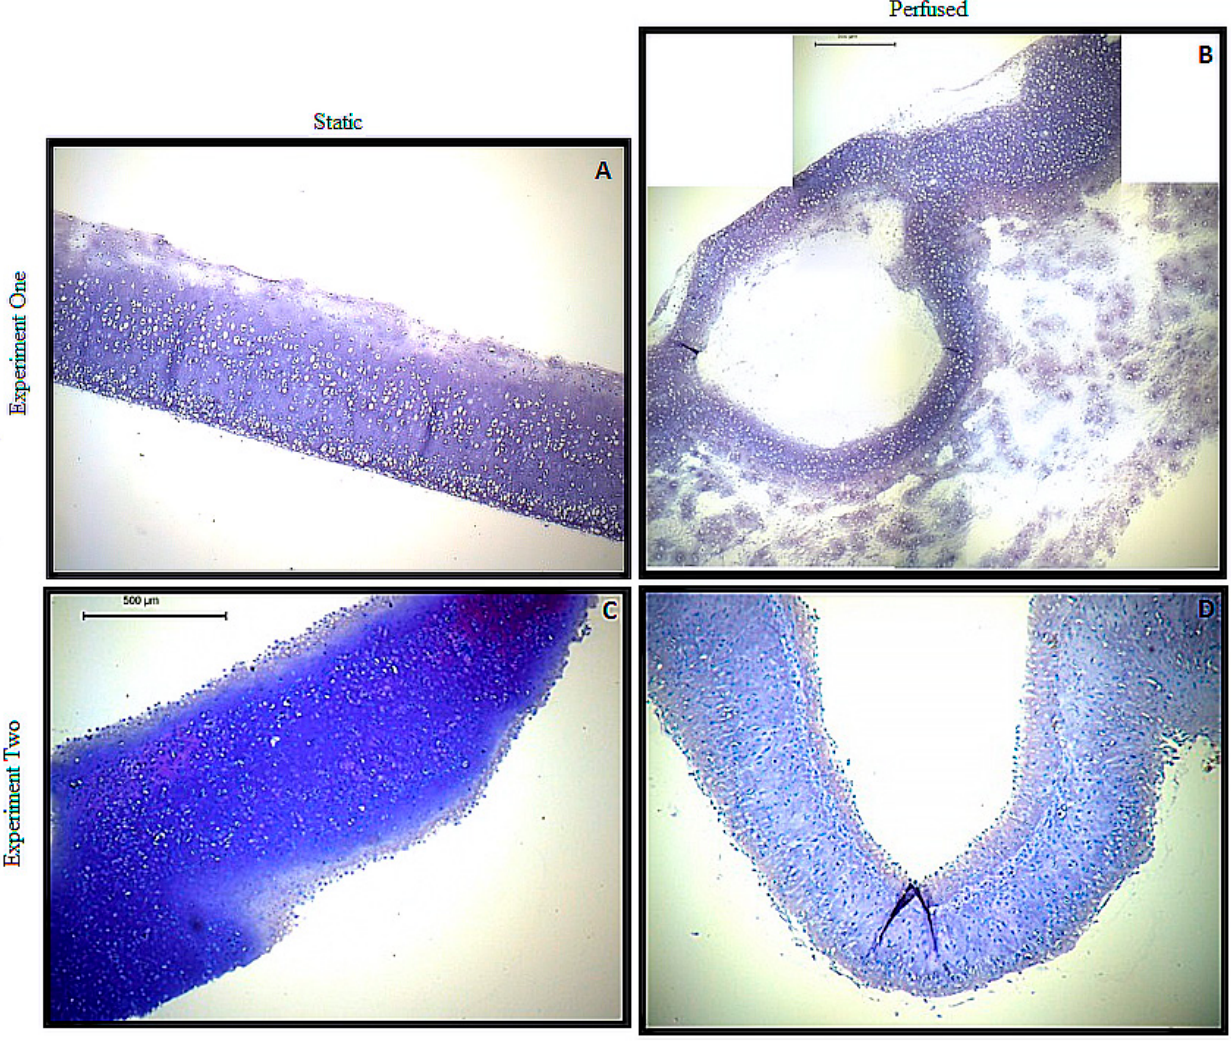
Figure 7. Toluidine Blue histology from Methods 1 and 2. ( A ) Method 1, Static; ( B ) Method 1, Perfused; ( C ) Method 2, Static; ( D ) Method 2, Perfused. * all scale bars are 500